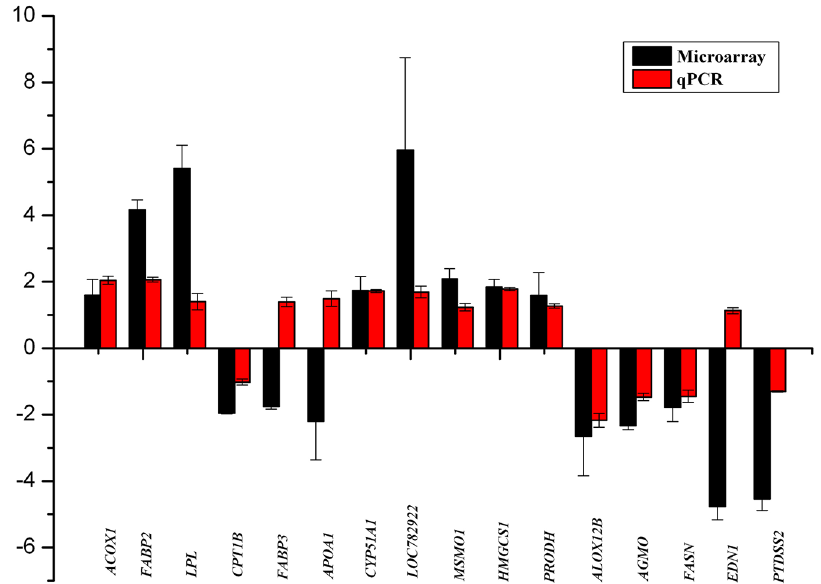
Fig 4. Validation of sixteen microarray differentially expressed genes by RT-qPCR. The fold-change value is expressed as positive when the genes are highly expressed in transgenic cattle and as negative when the genes are highly expressed in wild-type cattle. The gene names are displayed below the